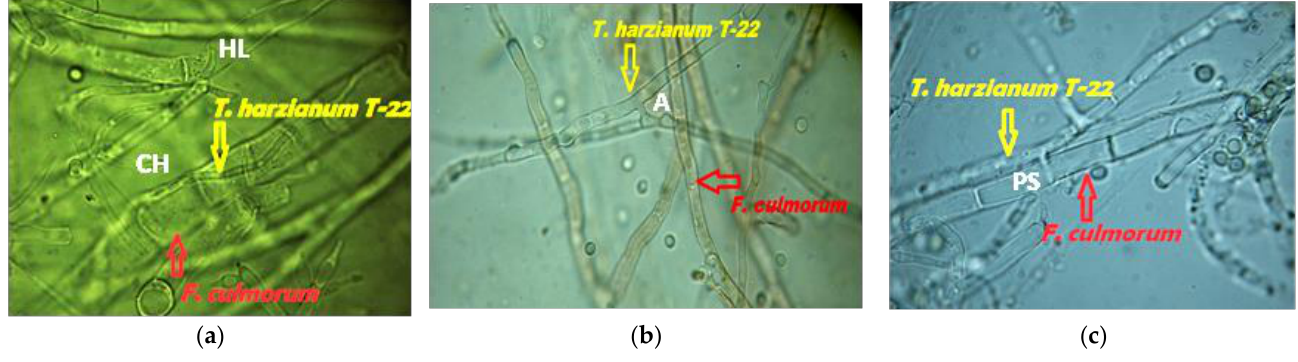
Figure 2. Micrograph of the hyphal interactions between T. harzianum T-22 and F. culmorum : ( a ) and ( b ), coiling hypha (CH), appressoria (A), and hyphal lisis (HL) (resolution: ( a ) 150×; ( b ) 100×); ( c ) penetration structures (PSs) (resolution 120×). Yellow and red arrows indicate the specific micro- structures of T. harzianum T-22 and F. culmorum , respectively.